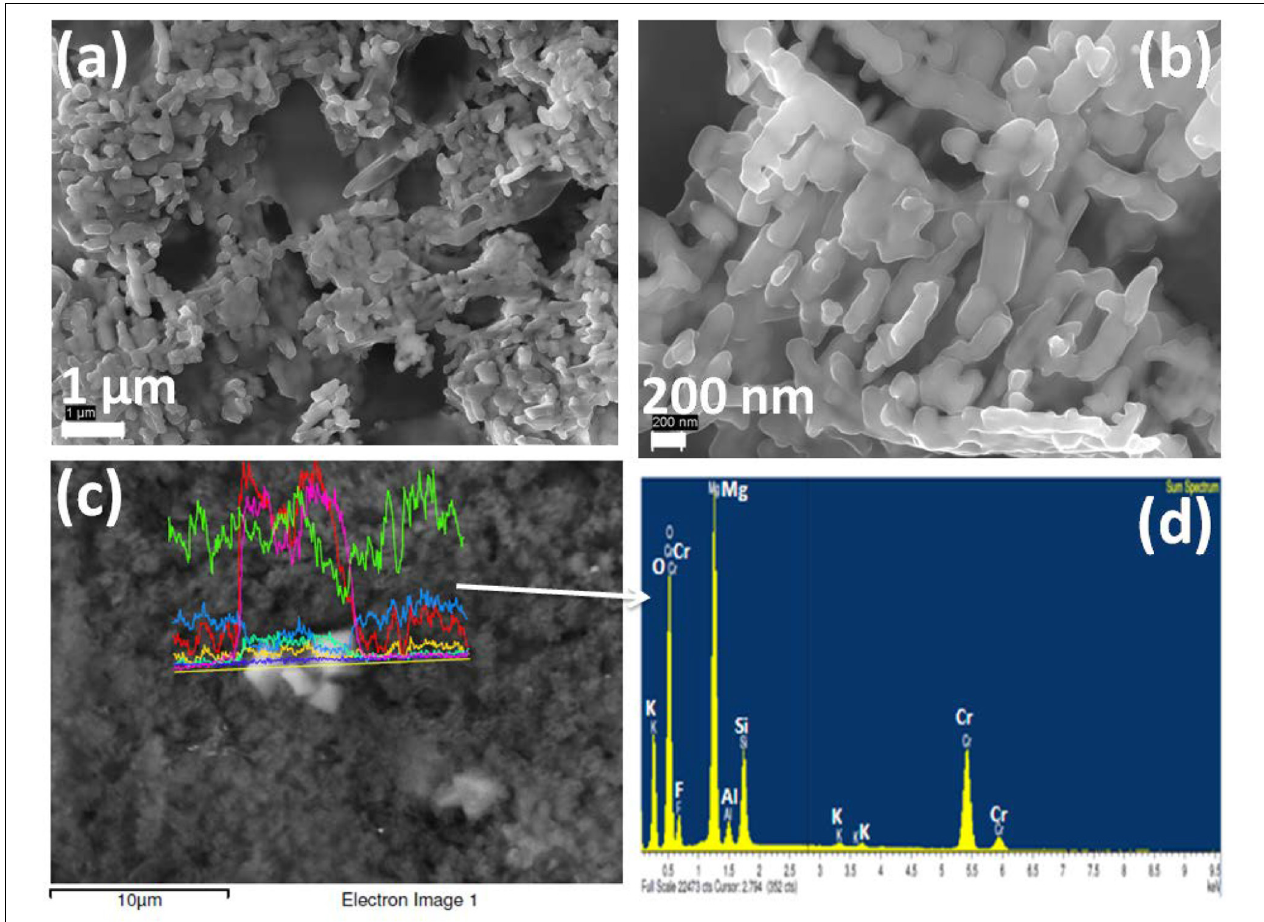
FIGURE 6 | (a,b) FESEM photomicrographs (in 1 µ m and 200 nm) and (c,d) EDX pattern of K 2 O-MgO-Al 2 O 3 -B 2 O 3 -SiO 2 -F glass containing 2 mol% K 2 Cr 2 O 7 content, Cr-2; showing the dispersed crystalline phases (MgCr 2 O 4 , MgF 2 , K 3 CrF 6 and